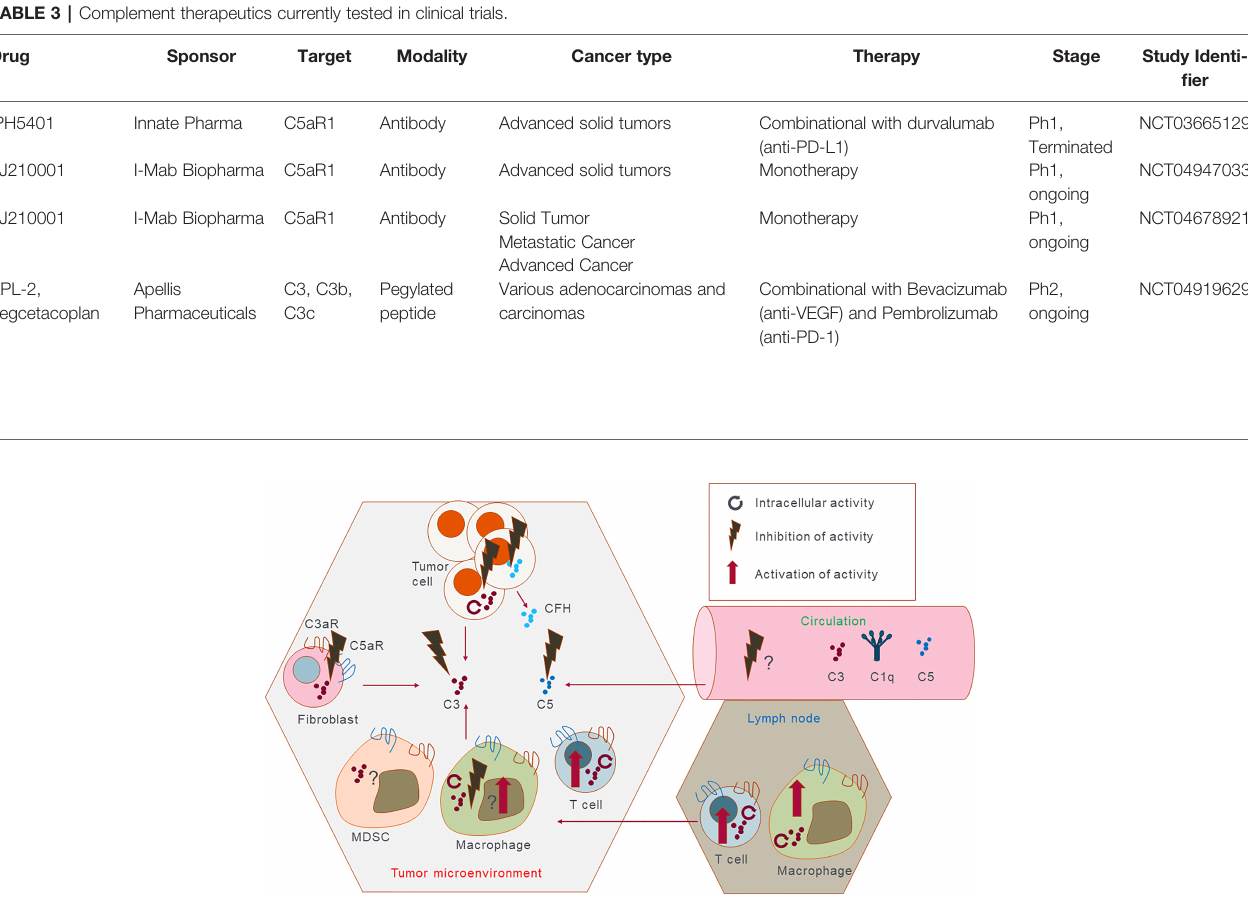
FIGURE 3 | Potential therapeutic intervention points. Complement proteins can be expressed and secreted by almost all cells in the tumor microenvironment, and in the lymph nodes and are present in serum. This cartoon outlines potential targets either intracellularly or extracellularly that could be either inhibited or activated in the case of the immune cells. It is possible that in the future complement inhibiting therapeutics should be able to act extracellularly to promote immune cell antitumor immunity. Reversely intracellular complement in immune cells can be promoted as it is expected to have antitumorigenic effect and promote in fl ammation. Discreet complement targets present in the tumor cells but not in the immune cells and vice versa would have to be discovered to obtain full clinical ef fi cacy of complement targeting